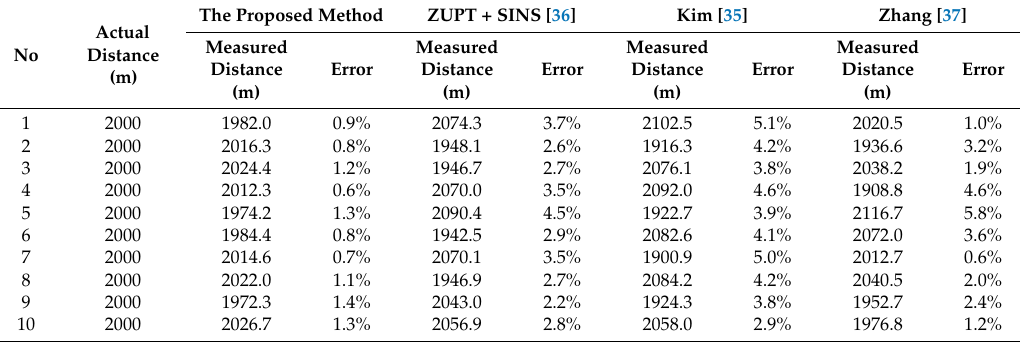
Table 4. Experimental results for long distance walking